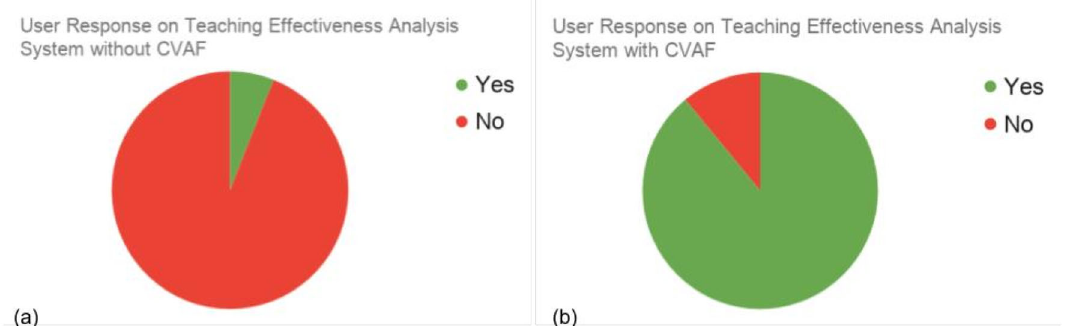
Fig. 11 User responses on installation of teaching effectiveness analysis system with and without CVAF